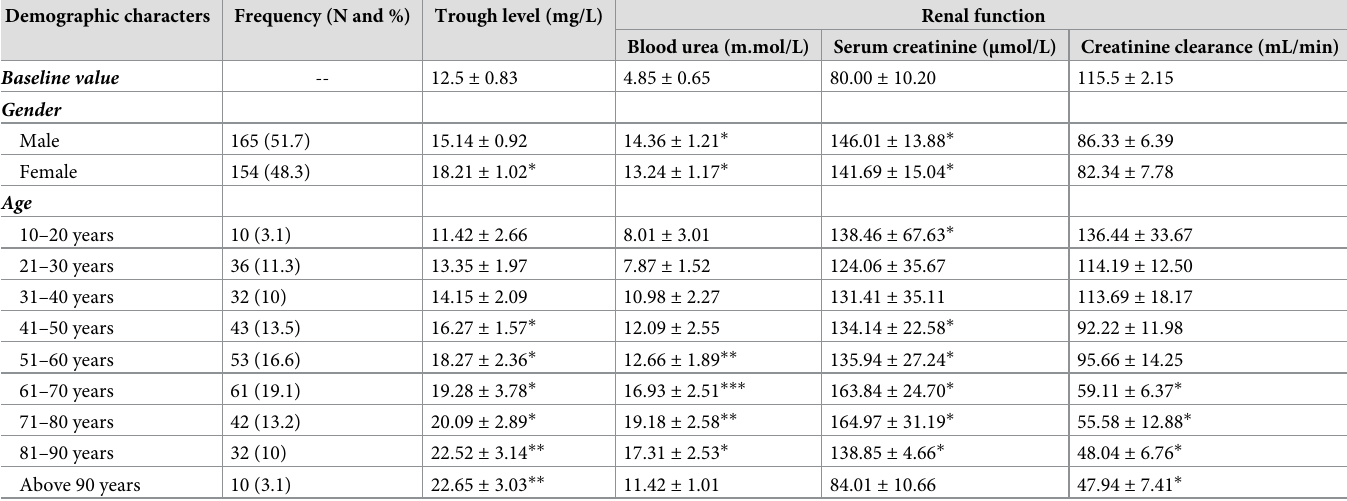
Table 1. Effect of vancomycin on the renal function in patients according to demographic characters. Demographic characters Frequency (N and %) Trough level